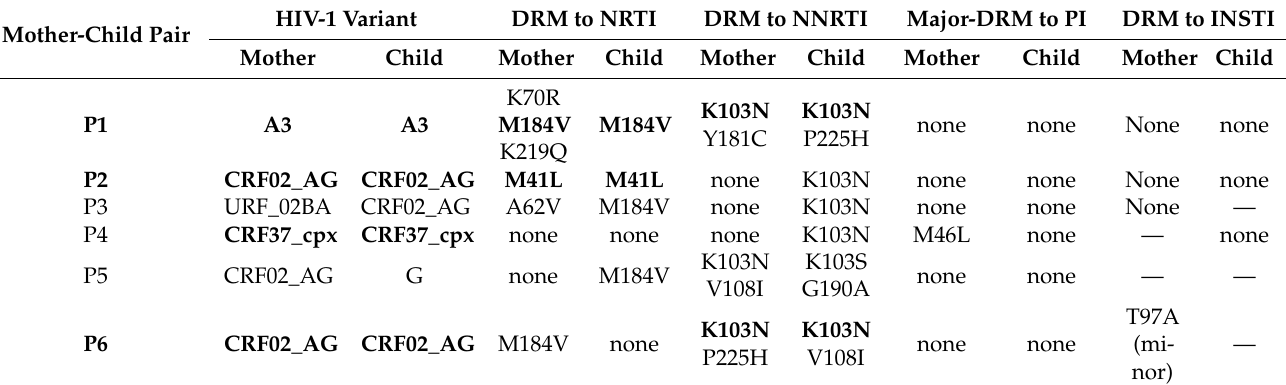
Table 2. HIV-1 variants and drug resistance mutation in ART-treated mother-child pairs. HIV-1 Mother-Child Pair